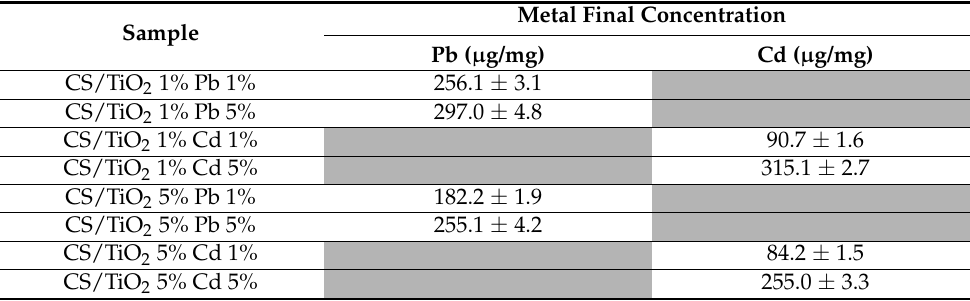
Table 3. Cd and Pb removal capacity of chitosan/TiO 2 composite membranes.